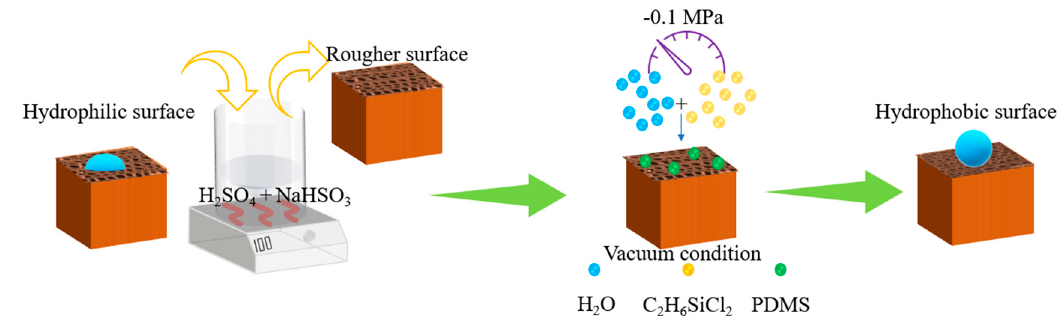
Figure 1. Schematic illustration of description of the entire process.